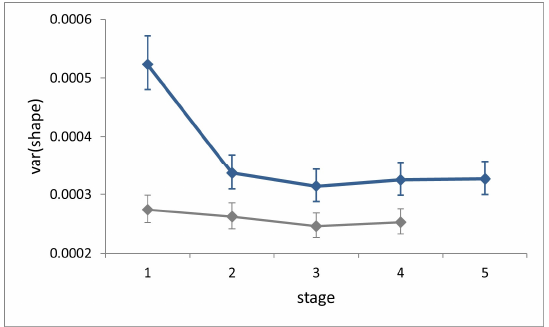
Figure 5. Ontogenetic progression of symmetric shape variance during the five larval stages in P. brassicae . Continuous blue line, field dataset; grey line, laboratory dataset (from [8]). Bars are 95% confidence intervals.